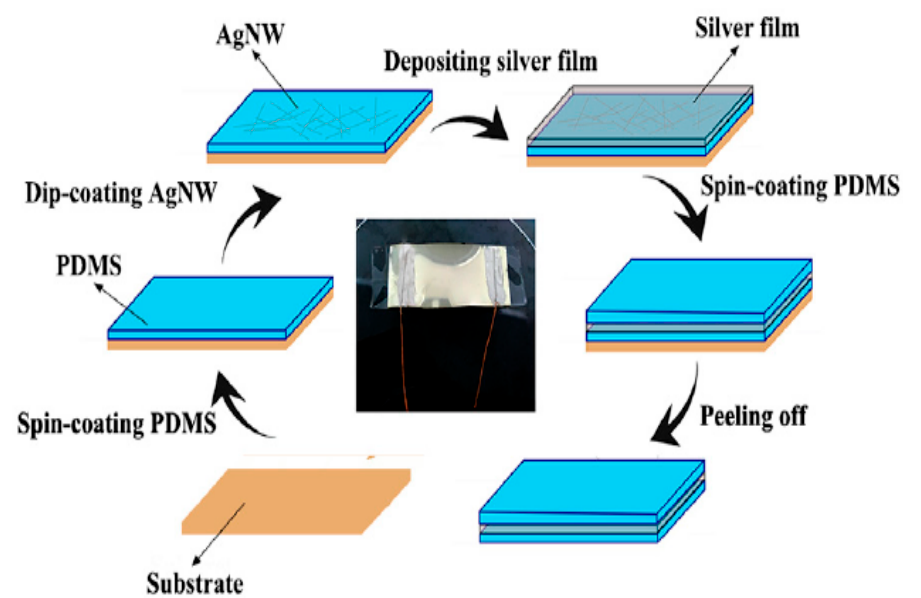
Figure 8. Schematic illustration of steps involved in fabricating strain sensors by deposition of the silver film. Adapted under the terms of the CC-BY 4.0 license from Ref. [77] Copyright 2019, The Authors, published by MDPI.